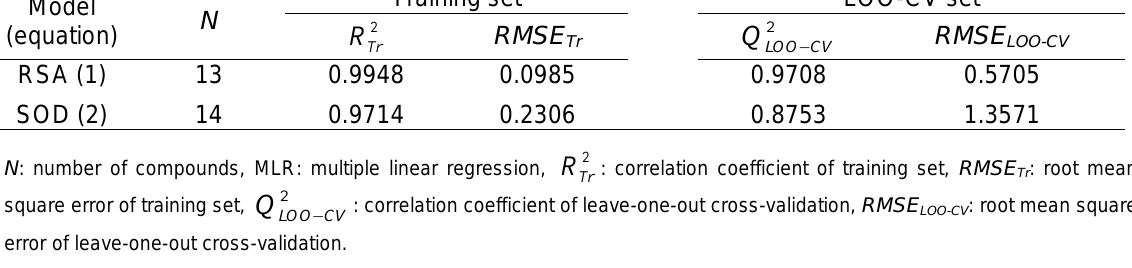
Table 3: Statistical results of predictive QSAR models using MLR method Model